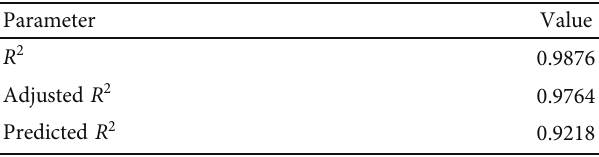
Table 6: Model fi t statistics (Source: Design-Expert 13 Software). Parameter